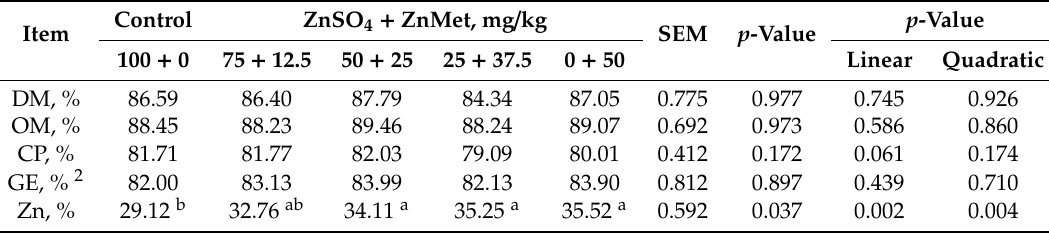
Table 3. E ff ects of dietary substitution of ZnSO 4 by low levels of ZnMet on apparent total tract digestibility (ATTD) of nutrients for 37- to -79-d-old piglets 1